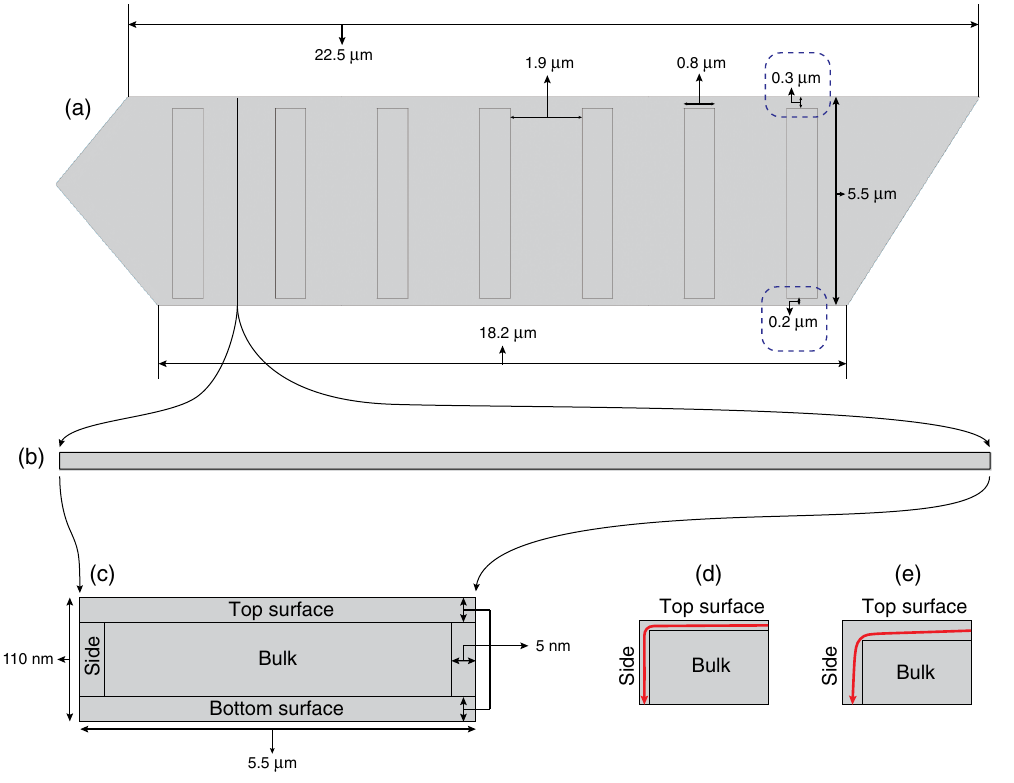
FIG. 7. (a) Schematic top view of the BSTS flake. (b) The cross section of the BSTS flake with the actual aspect ratio. The surface channel regions cannot be shown in this schematic figure because of the small surface thickness (about 5 nm) compared to the thickness of the flake (about 110 nm). (c) An exaggerated view of the cross section of the BSTS flake corresponding to the region shown in (b). (d),(e) Influence of the surface thickness on the current path near the edge.